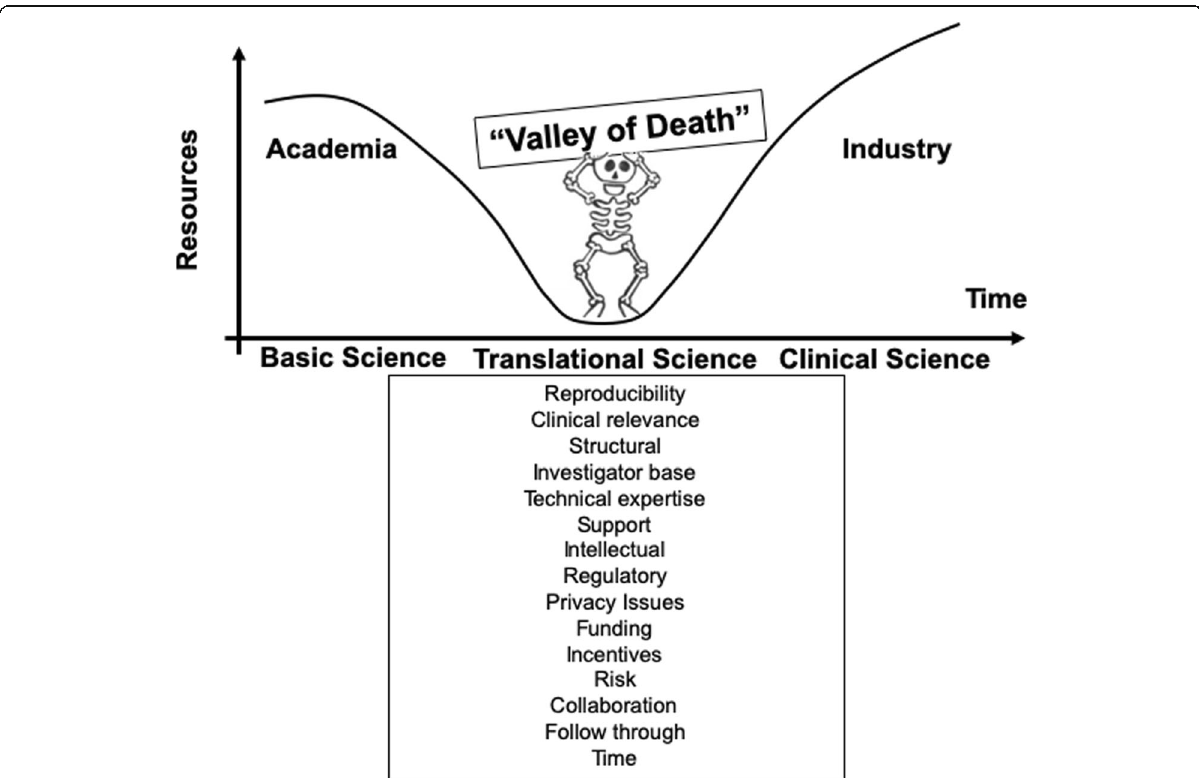
Fig. 2 Illustration of the valley of death in biomedical research. Between basic scientific research and clinical research is what ’ s known as translational research often referred as “ the Valley of Death, ” where promising discoveries meet their demise. To cross the “ Valley of Death, several key requirements must be in place to move these discoveries into new treatments, diagnostics and